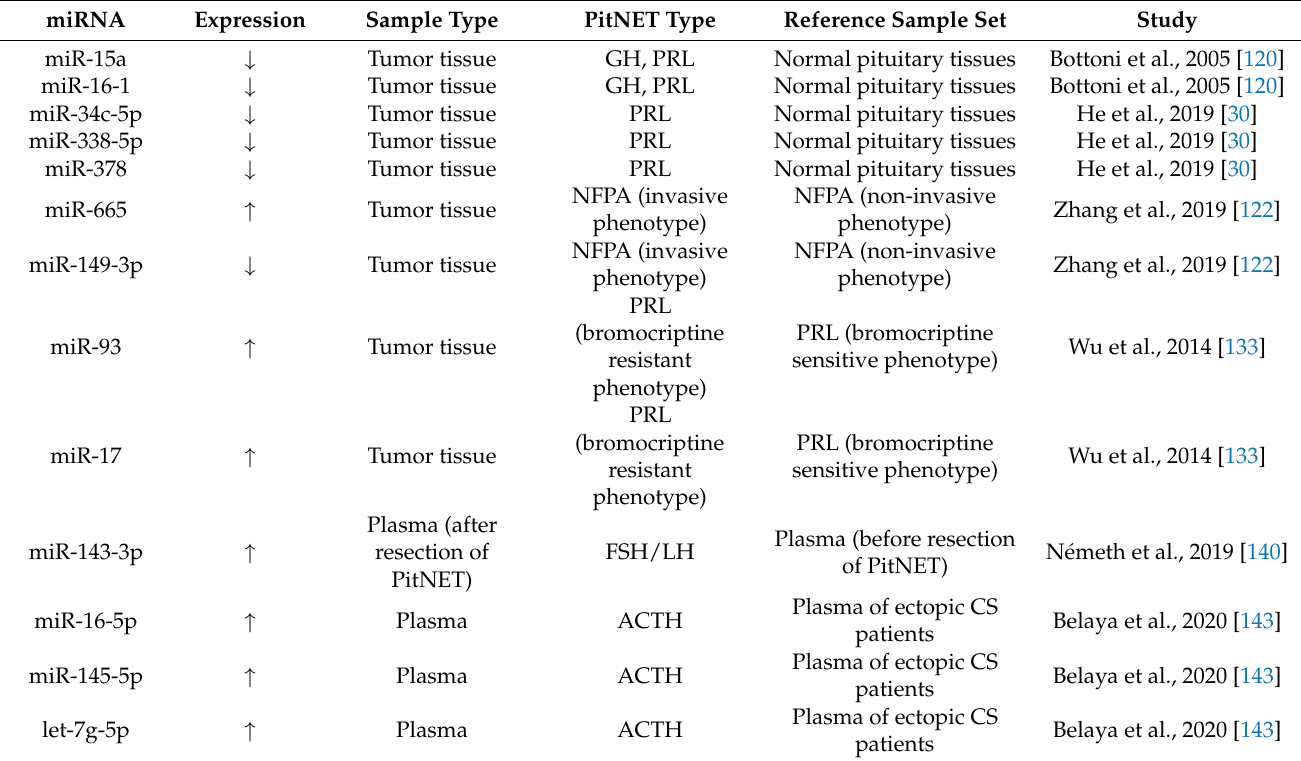
Table 3. Studies on PitNET associated